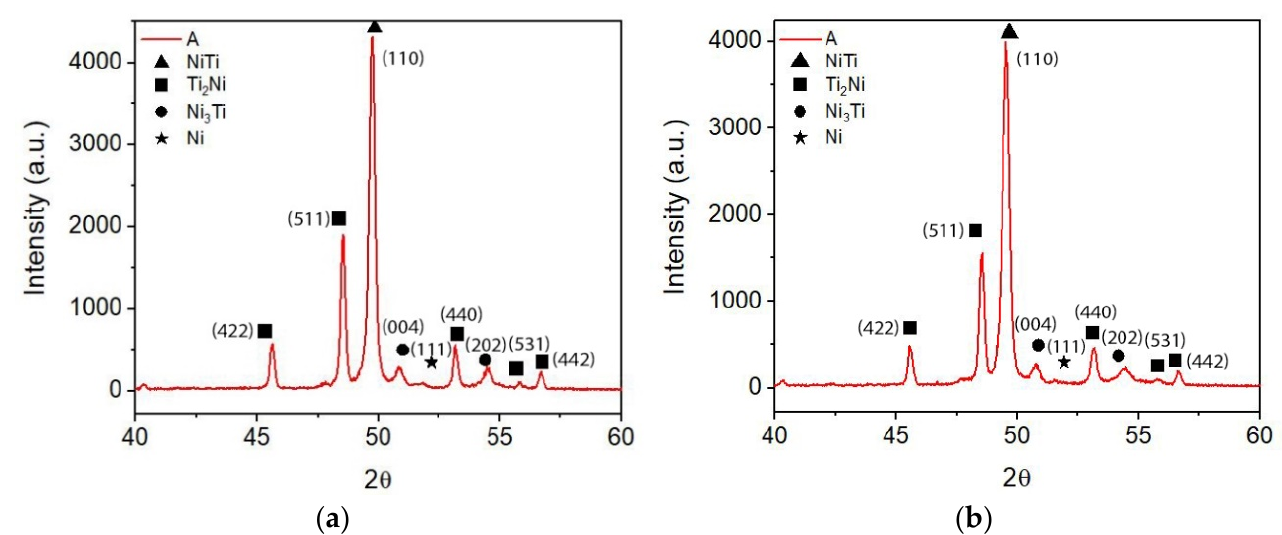
Figure 5. X-ray diffractograms of 3D object from filament A. ( a ) top, ( b ) bottom. With the addition of 1 wt.% of TiH 2 to NiTi prealloyed powder, no notorious differ- ence is observed. Based on the colors of the SEM micrographies (BSE) and EDS results, three distinct phases (NiTi, NiTi 2, and Ni 3 Ti) are identified (Figure 6, Table 7). The x-ray diffractogram analysis clearly shows the presence of NiTi, NiTi 2, and Ni 3 Ti and also Ni from virgin powder (Figure 7). In what concerns the percentages of NiTi and NiTi 2, there is a tendency for a small increase of NiTi 2 percentage in filament B.